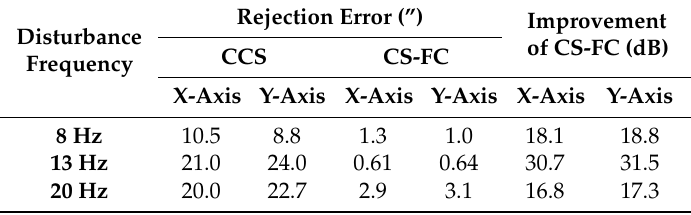
Table 1. The disturbance rejection performance of CCS and